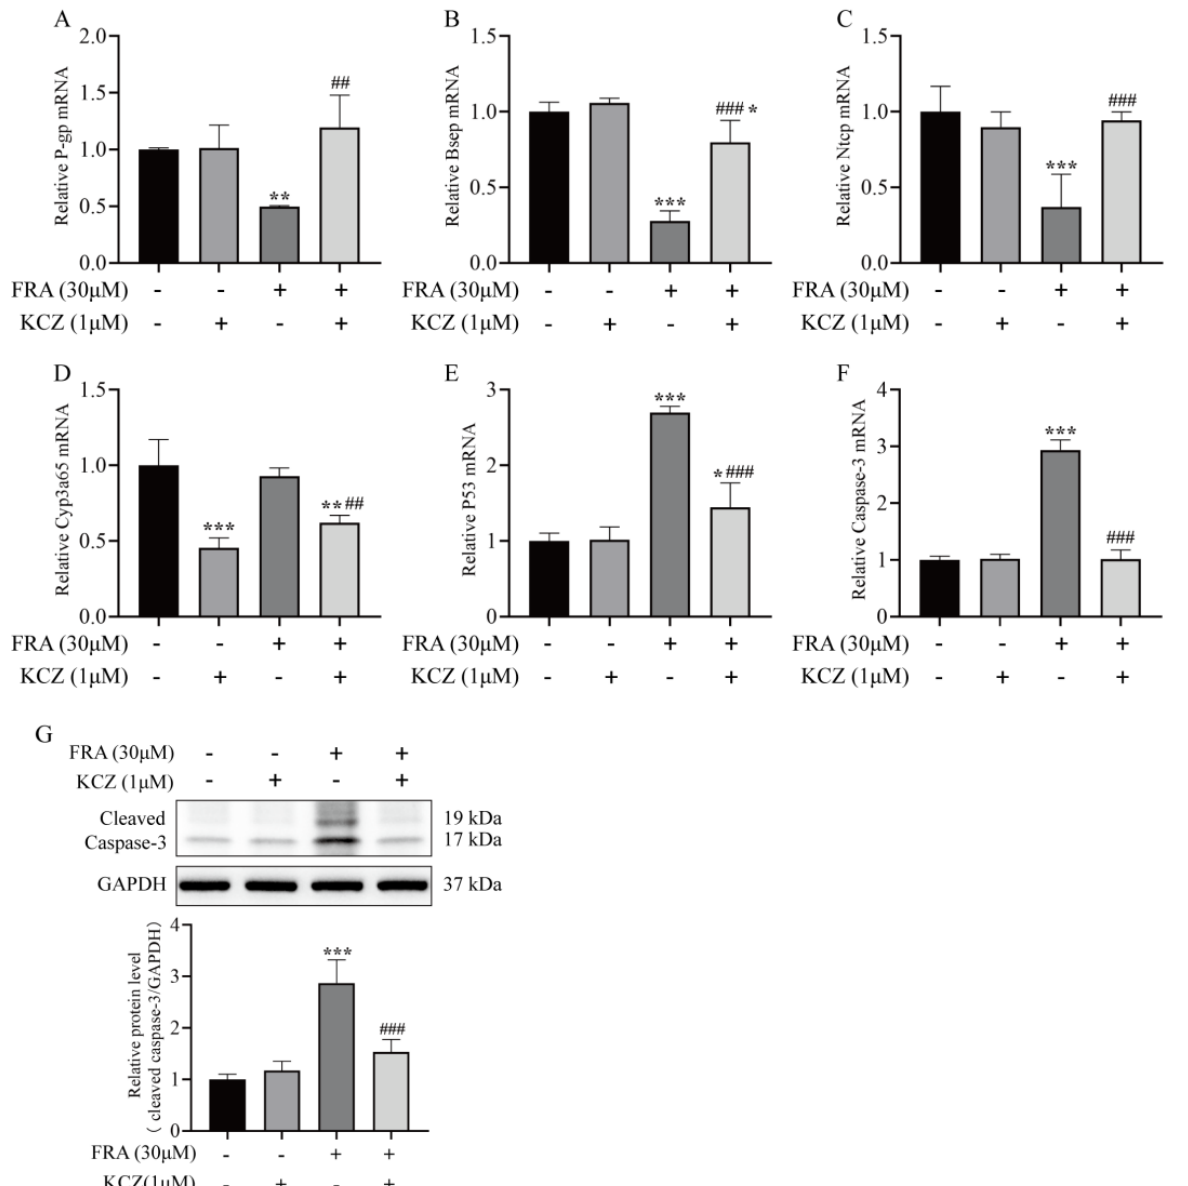
Figure 7. KCZ altered the expression patterns of transporter and apoptotic proteins inhibited by FRA. The mRNA expression levels of P-gp ( A ), Bsep ( B ), Ntcp ( C ), Cyp3a65 ( D ), p53 ( E ), and caspase-3 ( F ) were detected by qRT-PCR analysis. ( G ) The protein expression level of cleaved caspase-3 was detected by western blot analysis. Data are presented as the mean ± SD. Each experiment was performed 3 times with 40 randomly selected zebrafish larvae. * p < 0.05 vs. control; ** p < 0.01 vs. control; *** p < 0.001 vs. control; ## p < 0.01 vs. FRA + KCZ; ### p < 0.001 vs. FRA + KCZ.